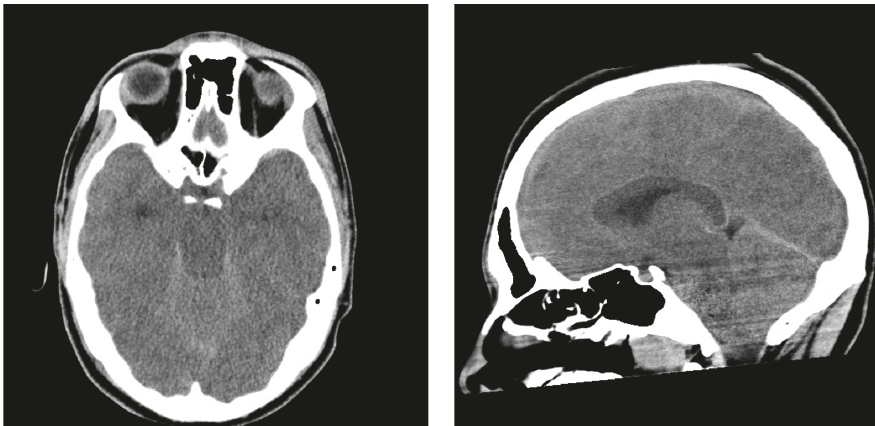
Figure 1: a (left): brain CT scan showing a diffuse edema with the disappearance of the gray/white matter limitation; b (right): herniation of the cerebellar tonsils.